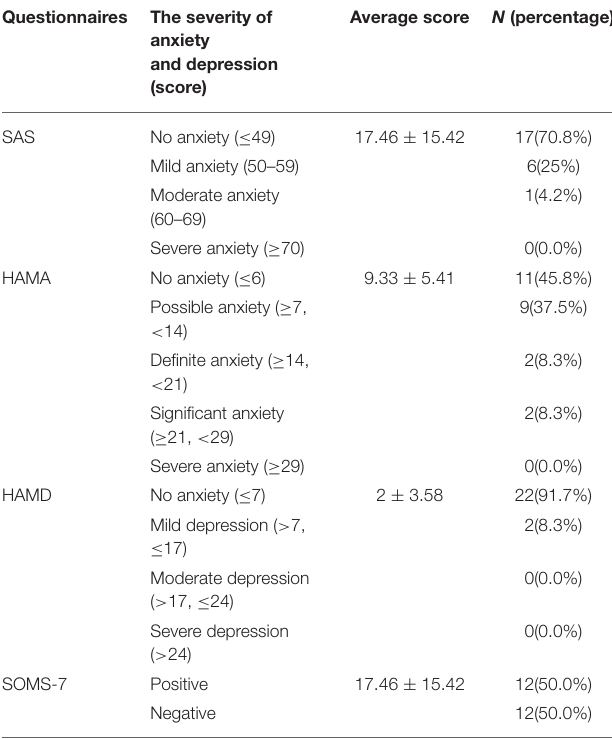
TABLE 1 | Evaluation of the state of emotional disorders. Questionnaires The severity of